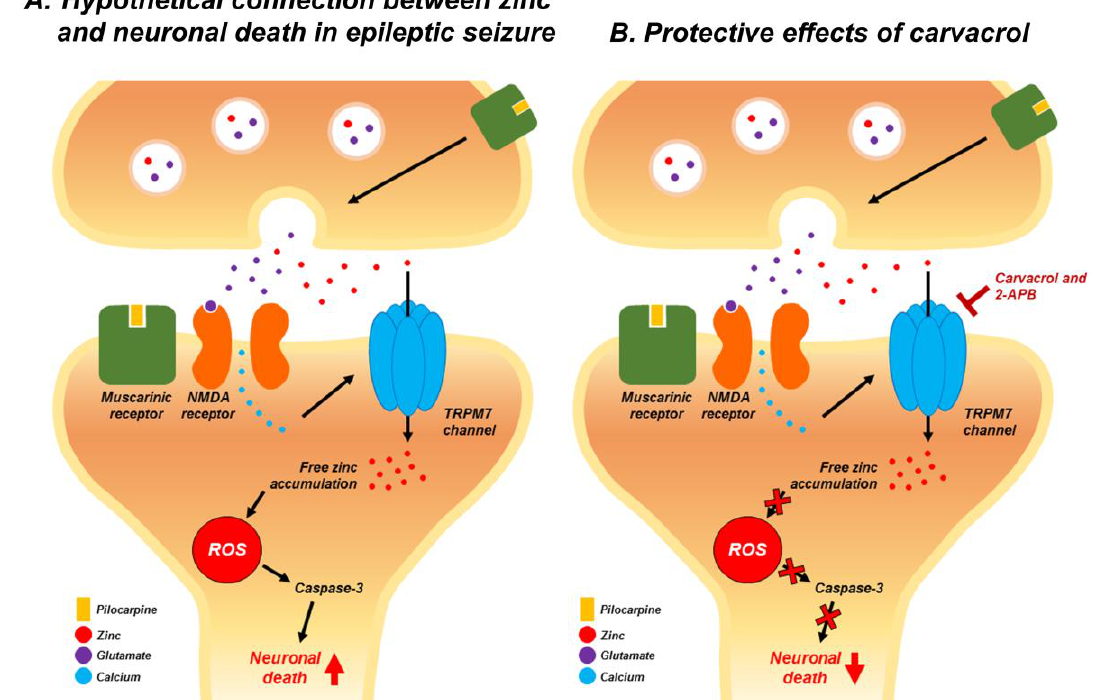
Figure 8. Possible association of zinc with neuronal death after pilocarpine-induced SE. This schematic drawing represents several chain reactions that may occur after carvacrol and 2-APB treatment in pilocarpine-induced SE. ( A ) These are the possible cellular pathways through which neuronal death occurs after pilocarpine-induced SE. ( B ) Blocking TRPM7 by carvacrol and 2-APB can inhibit several chain reactions that are thought to occur following pilocarpine-induced